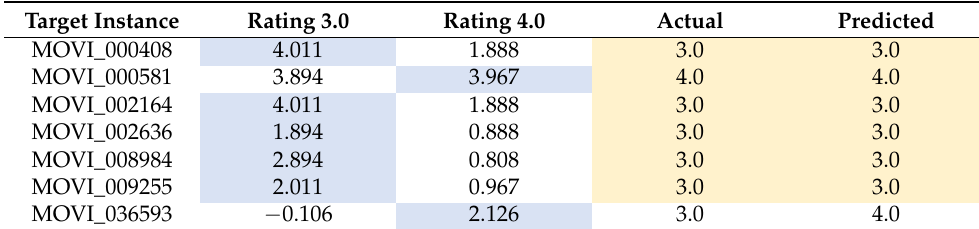
Table 4. Rating prediction